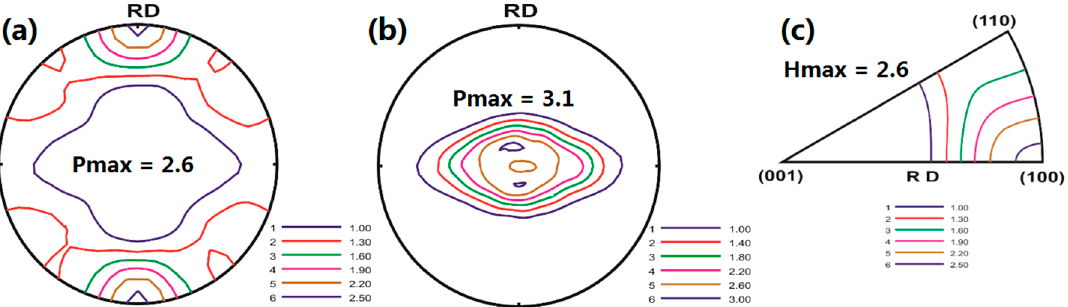
Figure 4. The initial pole figure of ZN10: ( a ) (10.0) pole figure; ( b ) (00.2) pole figure; ( c ) the inverse pole figure in RD. figure in